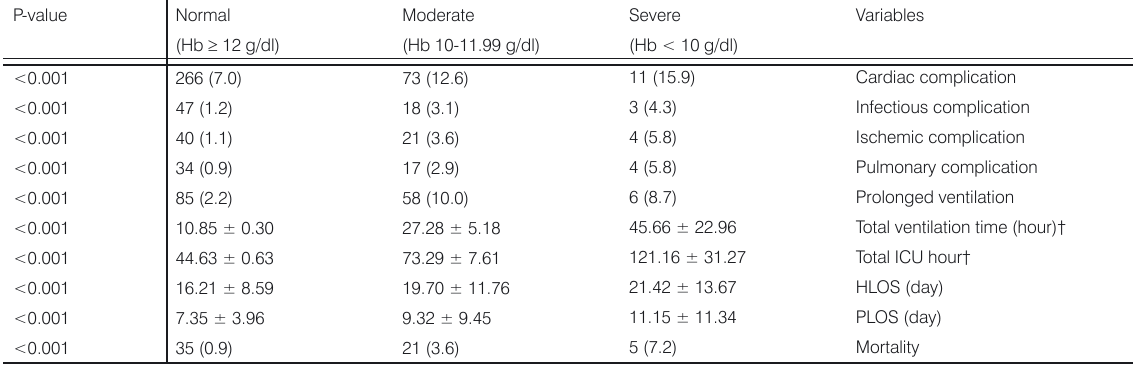
Table 3. Postoperative outcomes by preoperative Hgb classification*.